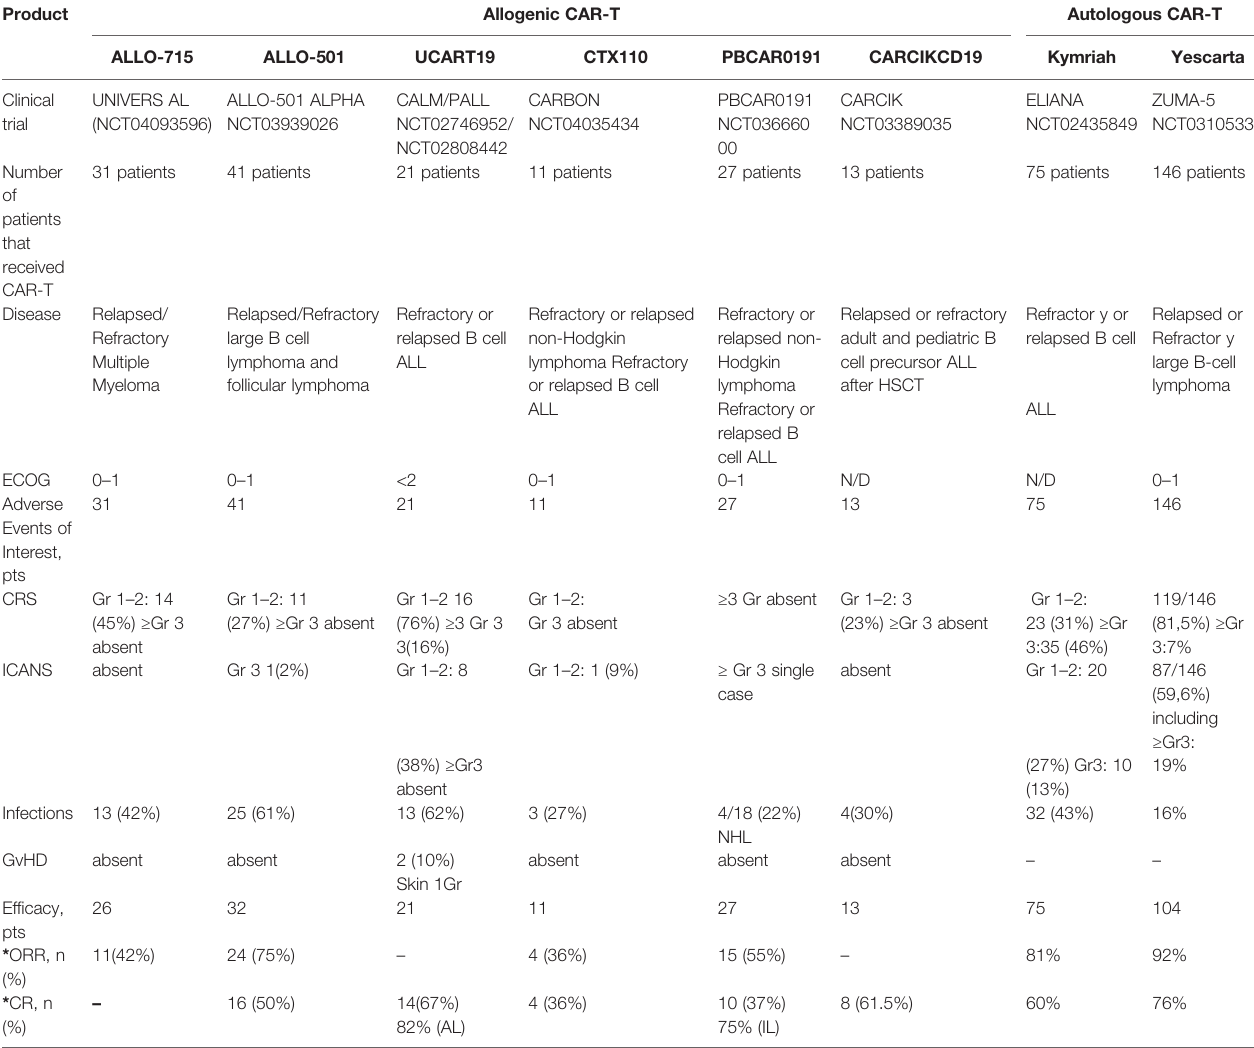
TABLE 3 | Ef fi cacy and adverse events associated with allogeneic and autologous CAR T cell